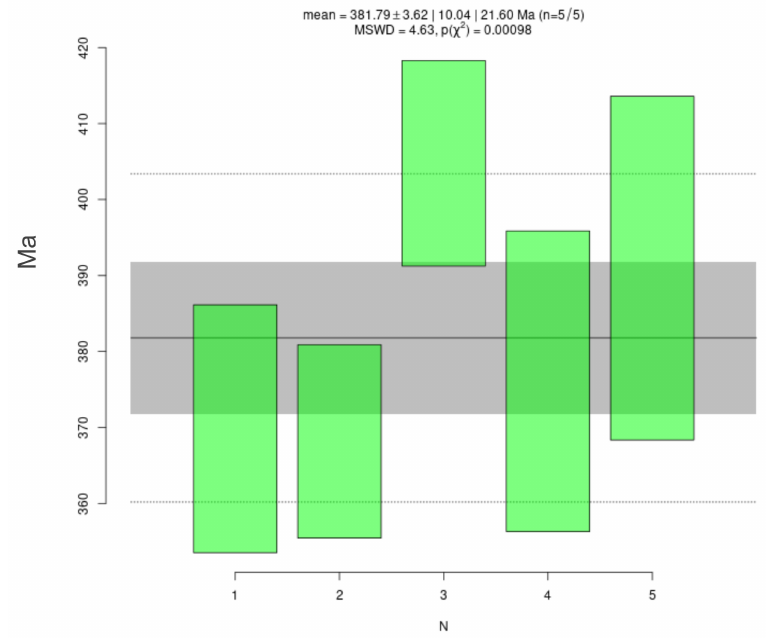
Figure 7. Weighted mean plot for pyrite from the Novogodnee-Monto deposit, constructed in the IsoplotR software ver.